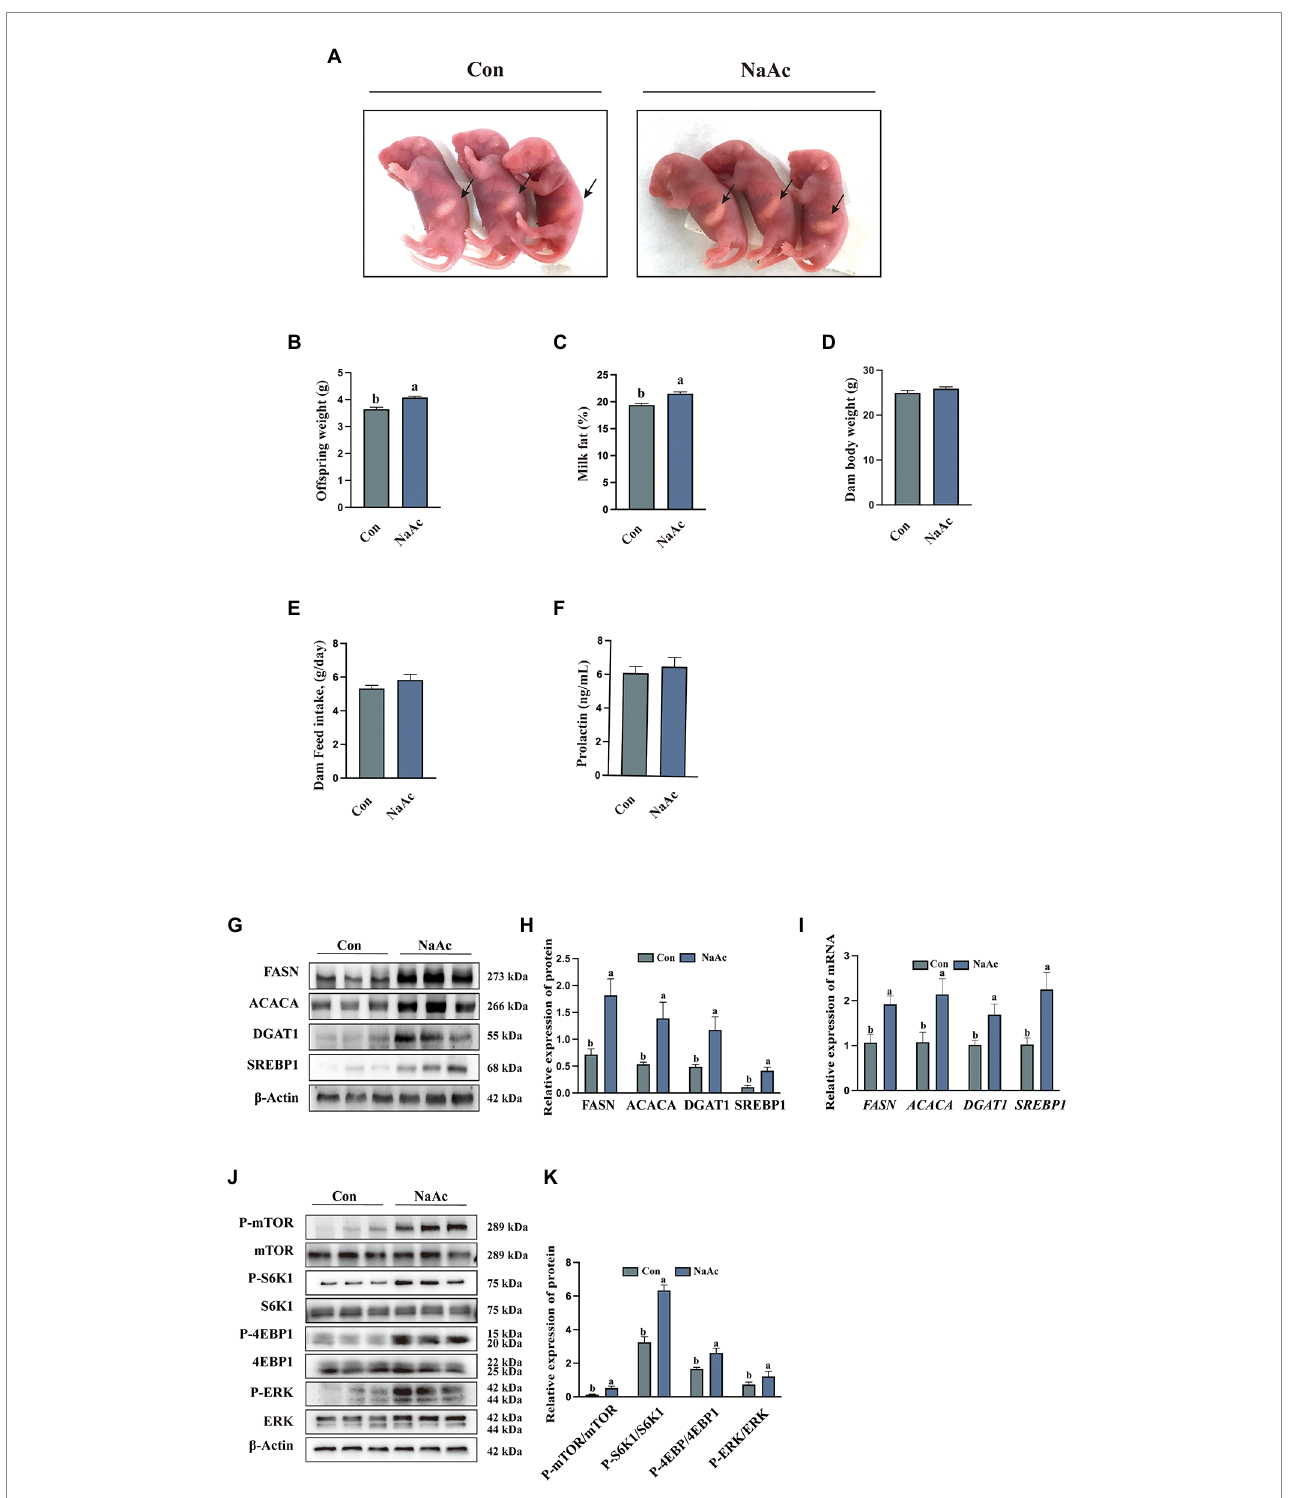
FIGURE 5 Effect of dietary supplementation of sodium acetate (NaAc) on milk fat synthesis and mTORC1 signaling in mice. (A) Milk in pups born by mothers, n = 3. (B) Offspring weight on d 7 of lactation, n = 7. (C) Milk fat content on d 7 of lactation, n = 7. (D) Dam baby weight on d 7 of lactation, n = 7. (E) Dam feed intake during lactation, n = 7. (F) Prolactin content in plasma of mice on d 7 of lactation, n = 7. (G,H) Relative expression abundance of proteins related to milk fat synthesis in mammary gland tissue, n = 3. (I) Relative mRNA expression abundance of target genes, n = 3. (J,K) Relative expression abundance of proteins related to GPCR and mTORC1 signaling pathways in mammary gland tissue, n = 3. All data with error bars are averages ± SEM. In histograms, no letter or the same letter above the bar graph indicates no significant difference ( p > 0.05), and different letters indicate a significant difference ( p <